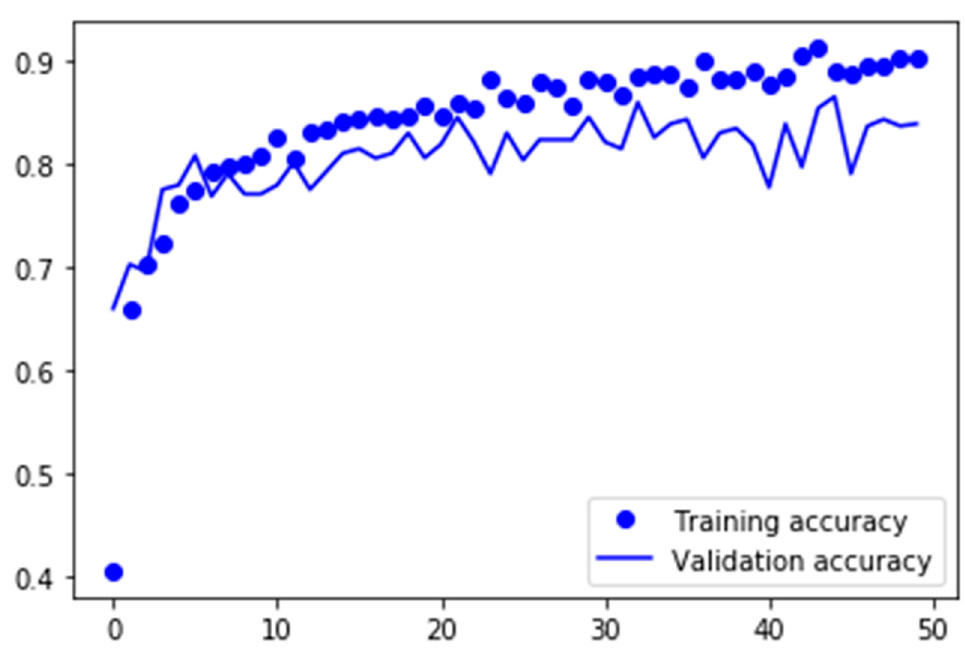
Figure 18. Training and validation accuracies for transferred VGG-16, trained over 50 epochs.